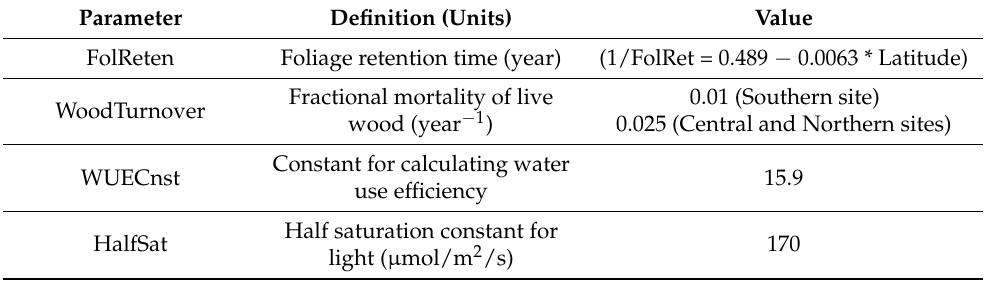
Table 3. Modified tree species parameters.